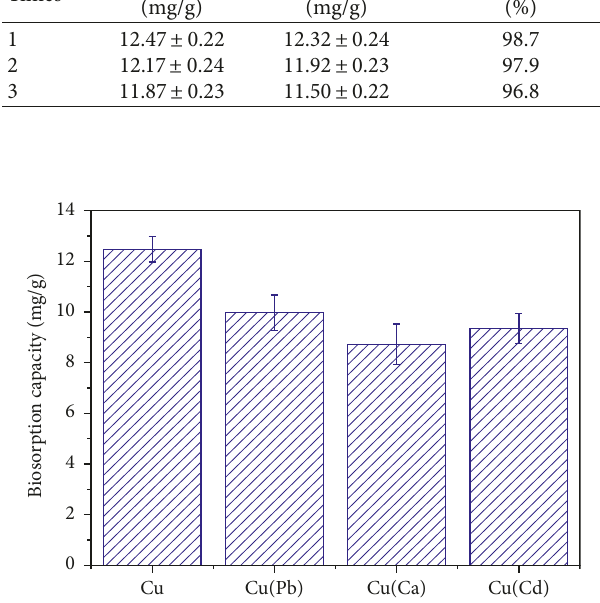
Figure 6: Biosorption capacity for Cu 2+ and binary metal ion mixtures with other kinds of divalent ions.